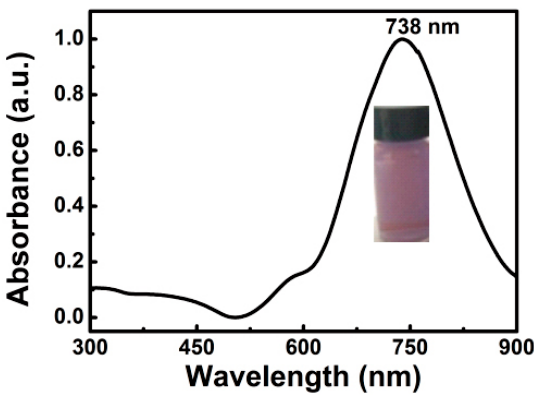
Figure 1. The optical absorbance spectrum and the photo (inset) of the Au nanocrystal colloidal solution.